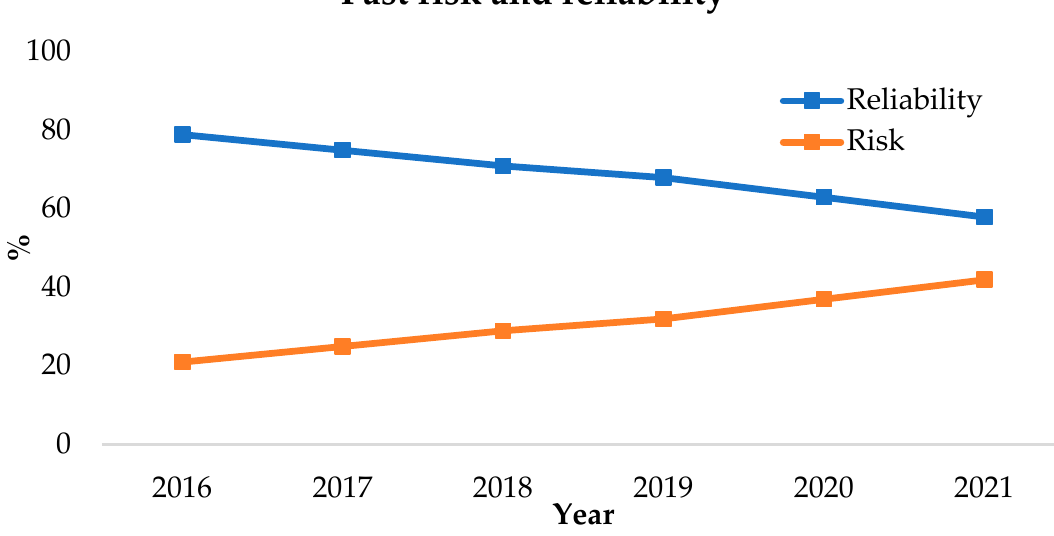
Figure 9. The dynamic failure risk of the MIC WWTP between 2016 and 2021.